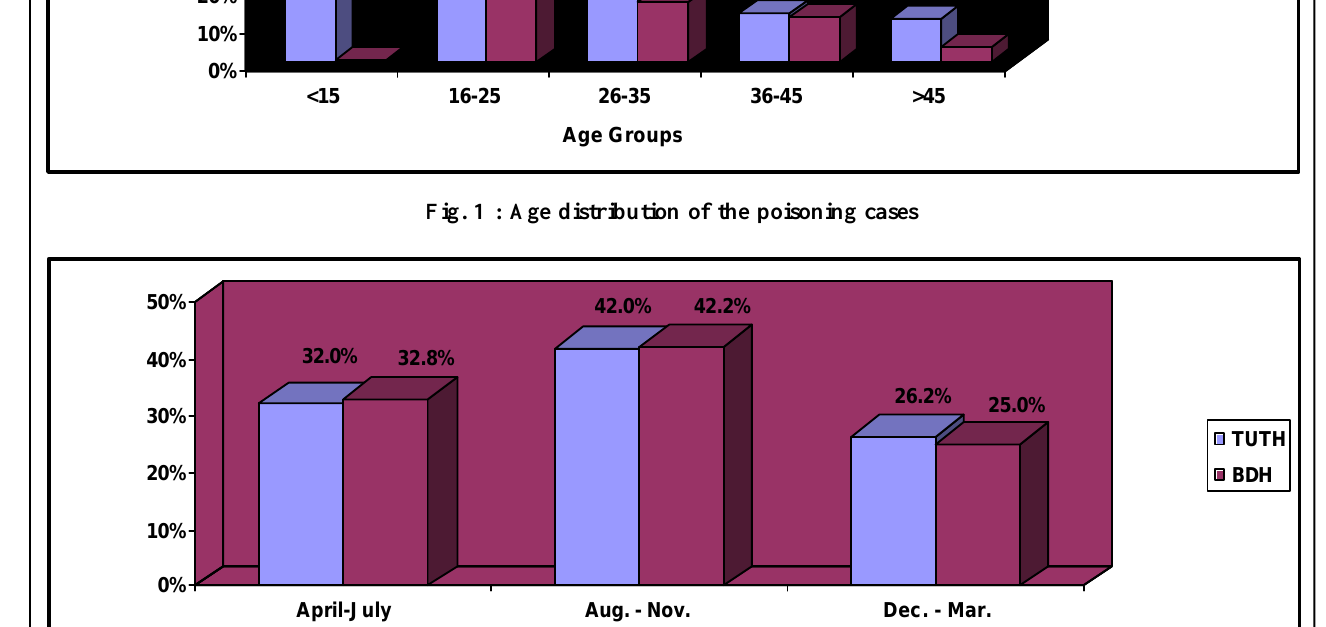
Fig. 2 : Month-wise distribution of the poisoning